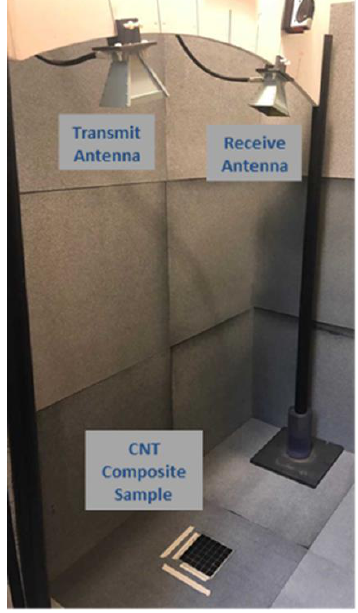
Figure 3. Arch setup used to measure microwave spectral response.